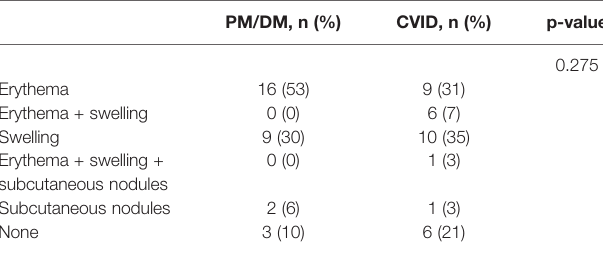
TABLE 3 | Comparison between local adverse events in PM/DM and CVID patients.